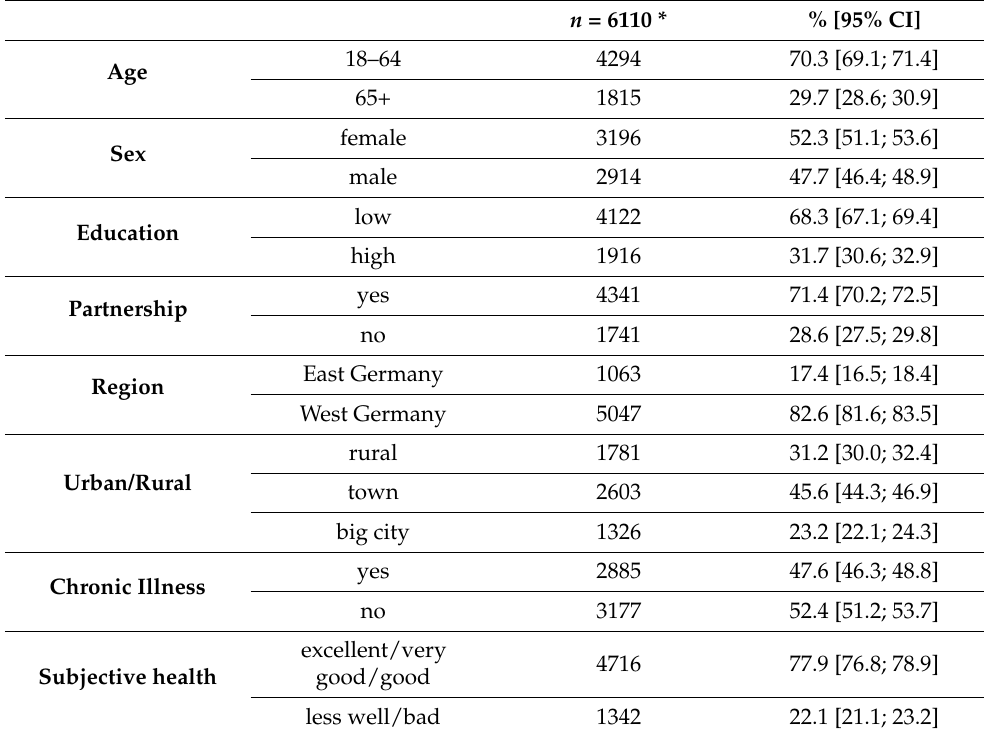
Table 1. Sociodemographic baseline data (weighted